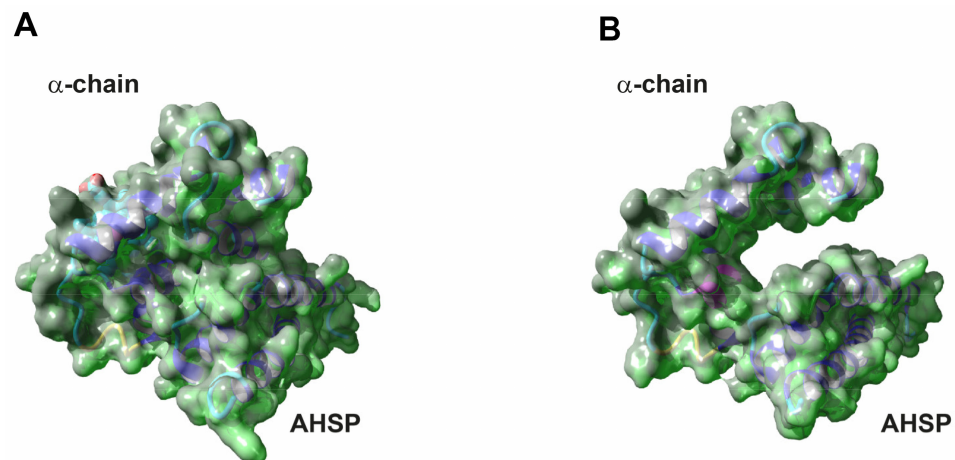
Figure 2. The 3D surface model of the Hb Campania. ( A ) The 3D surface model of the WT α -chain and of the Hb Campania ( B ) in complex with AHSP (PDB code